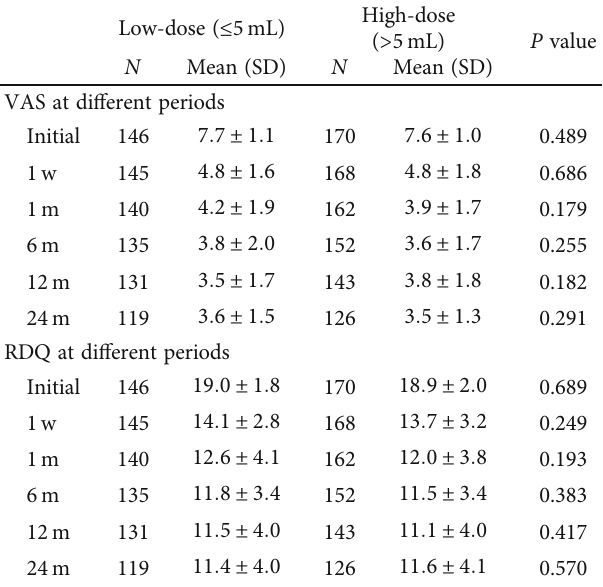
Table 2: The VAS and RDQ scores at the di ff erent time points of measurement.